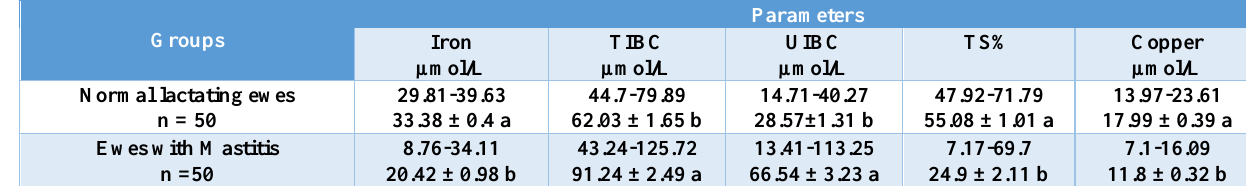
Different small letter (a, b) vertically means significantly different at (P˂